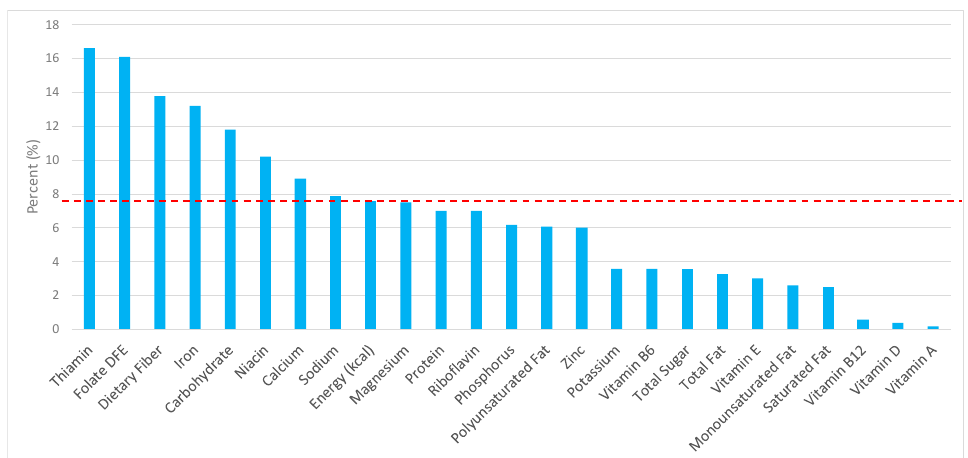
Figure 3. Breads, rolls, and tortillas as sources of energy and nutrients using NHANES 2009–2012, for adult males. Data are for adult males aged ≥ 19 years of age ( n = 5348), Day 1 intakes; dashed red line represents the percentage of energy provided and nutrients that surpass energy (kcal) contribution.